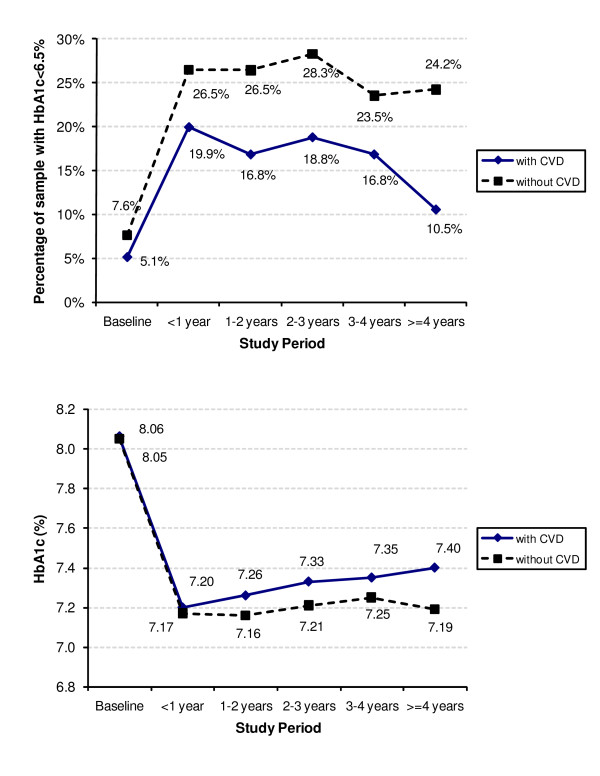
Glycemic control over time.